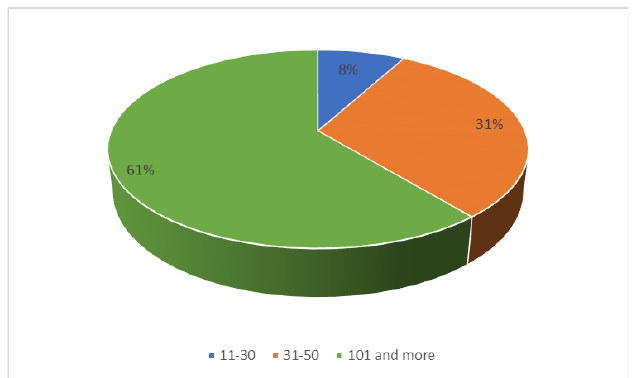
Fig. 1. Number of employees in the surveyed companies .